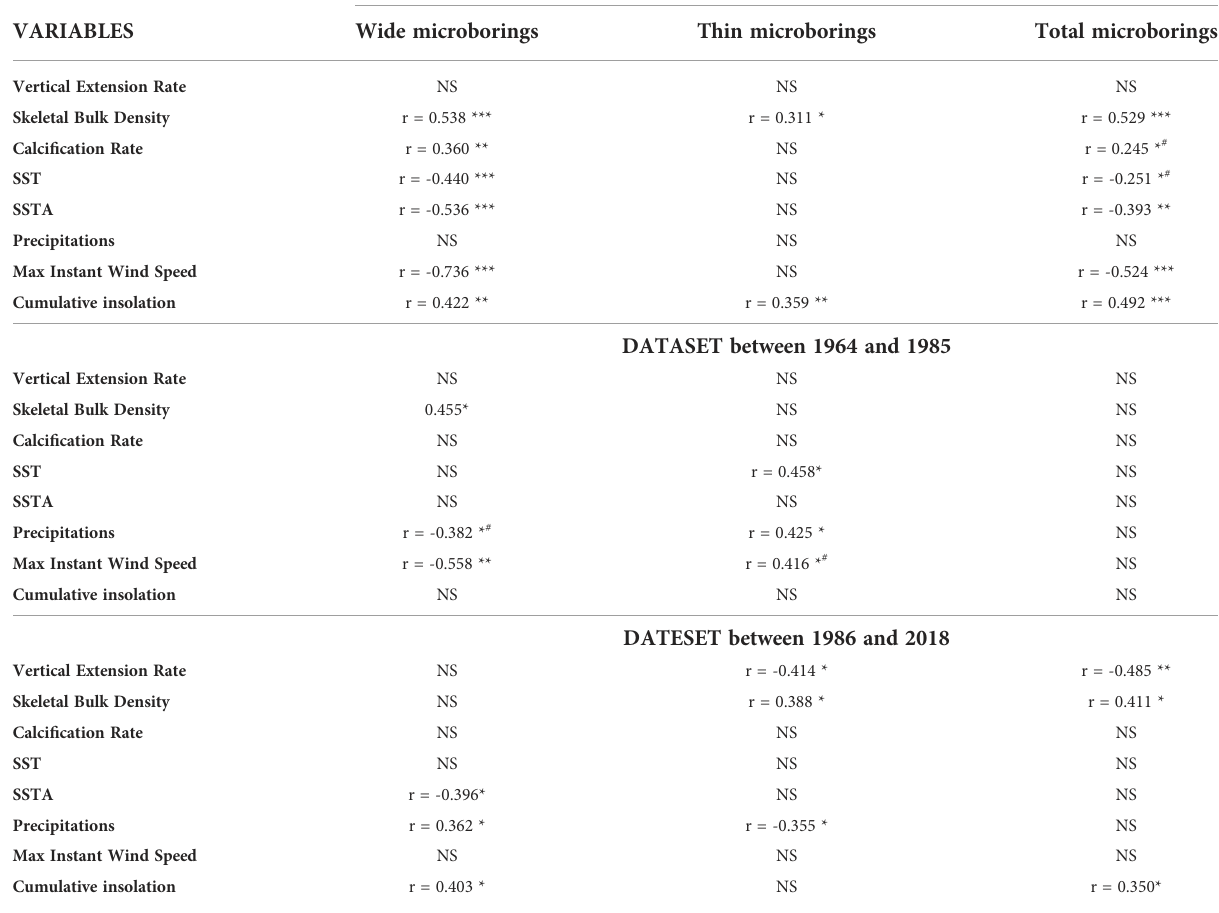
TABLE 3 Pearson ’ s correlations between the raw abundance of microborers (wide, thin or total) and raw environmental or coral growth variables over the last 50 years and per period before or after the